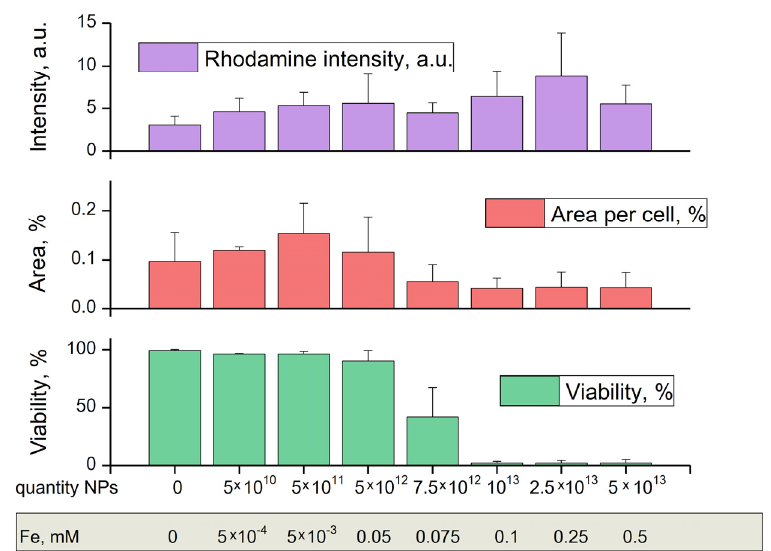
Figure 8. Rhodamine intensity in a fibroblast cell, the area occupied by a fibroblast cell relative to the entire frame area, and fibroblast cell viability after 24 h of exposure to TSC-IONPs of various concentrations. Results are presented as mean and SD for three independent experiments.